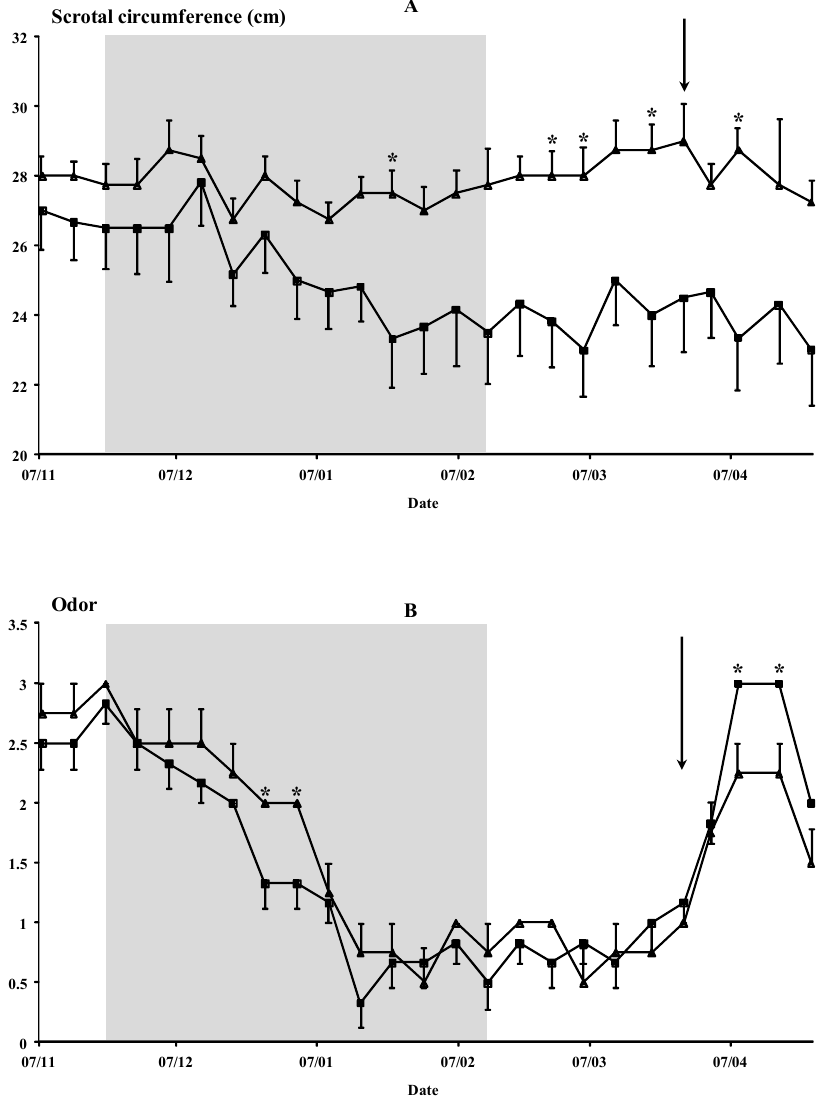
Figure 5 . (Experiment 2). ( A ) Scrotal circumferences and ( B ) odors of the males are used to induce the male effect. These males were submitted to a photoperiodic treatment, i.e., long days for three